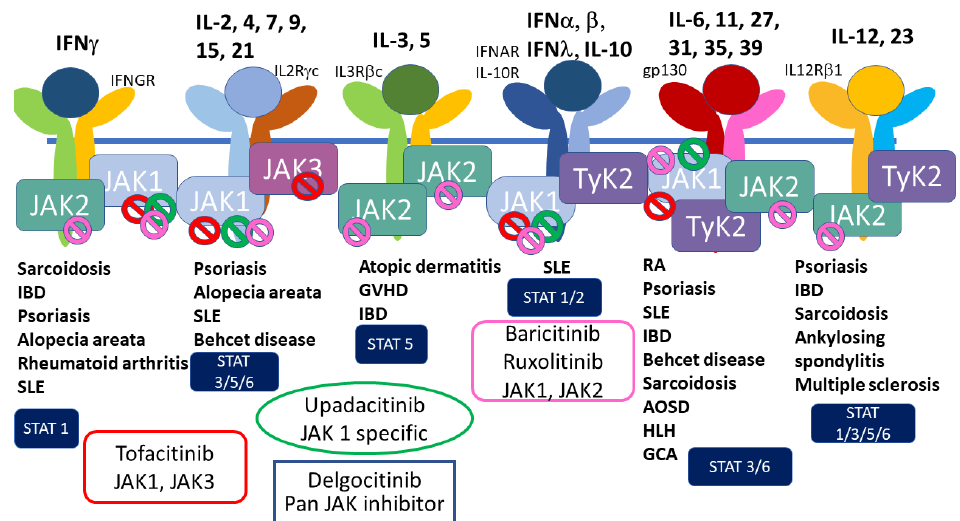
Figure 5. Several cytokine receptors utilize the JAK – STAT pathway to transduce their signals to the nucleus. Different cytokine receptors utilize different combinations of JAK family members and phosphorylate different STAT family members. Modified from reference [71].